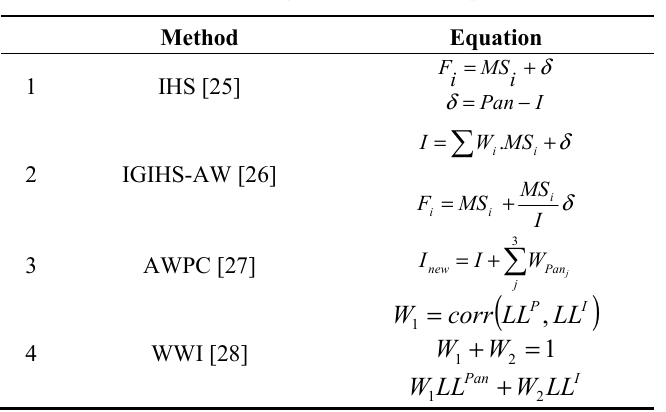
Table 1. Image fusion